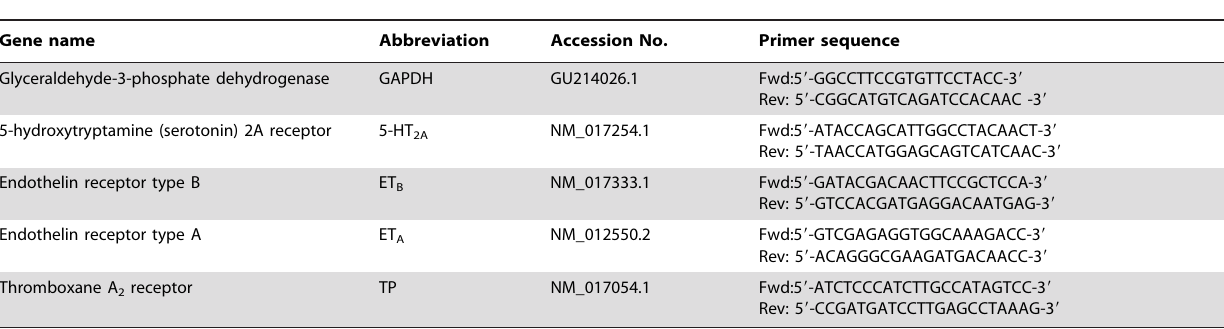
Table 2. Accession numbers and primer sequence for target